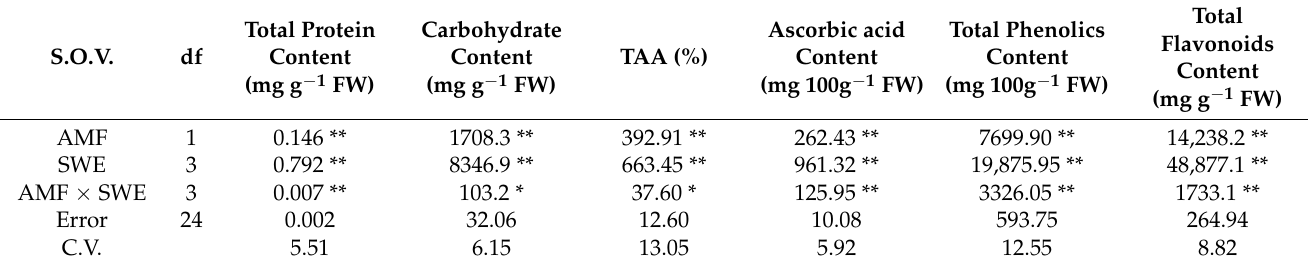
Figure 3. Effect of mycorrhiza (AMF) × seaweed extract (SWE) co-treatments on chlorophyll index (SPAD) ( a ), total proteins content ( b ), total carbohydrates content ( c ), and total antioxidant activity (TAA) ( d ) of lettuce plants. Different letters indicate significant differences according to LSD test at p < 0.05. AMF0 and AMF1 refer to without mycorrhiza and with mycorrhiza. Table 2. Analysis of variance (ANOVA) for the effects of arbuscular mycorrhiza fungi (AMF) inocula- tion and seaweed extract (SWE) foliar spray on physiological traits of lettuce